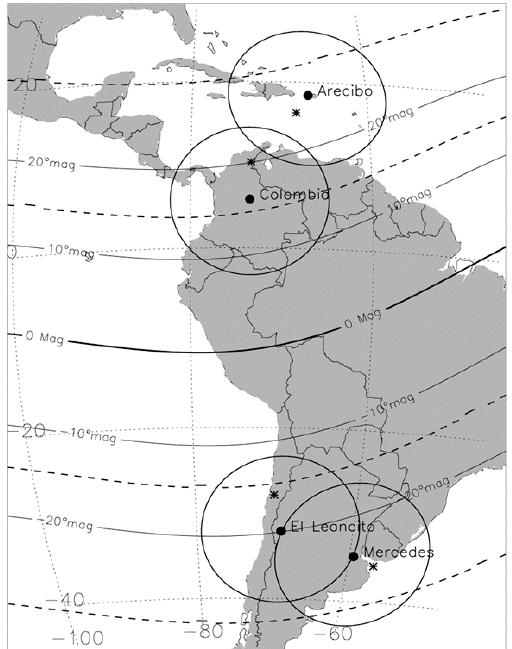
Figure 1. Map showing the locations and fields of view of the all-sky imagers used in this study. Circles represent the FOV at 250 km and zenith angles less than 80°. The black dots refer to the zenith at each location and asterisks identify the magnetically conjugate imager’s zenith. The magnetic equator and ±10° and ±20° magnetic latitude lines are indicated. The dashed curves represent the apex heights of 750 km and 2400 km.